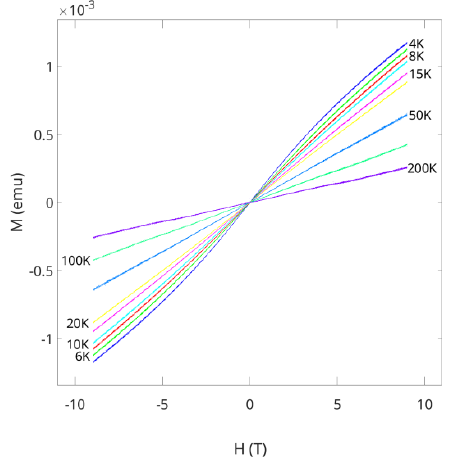
Figure 7. Field-dependent measurement of the magnetization for a crystalline sample of 4 , mounted in arbitrary orientation in the field .